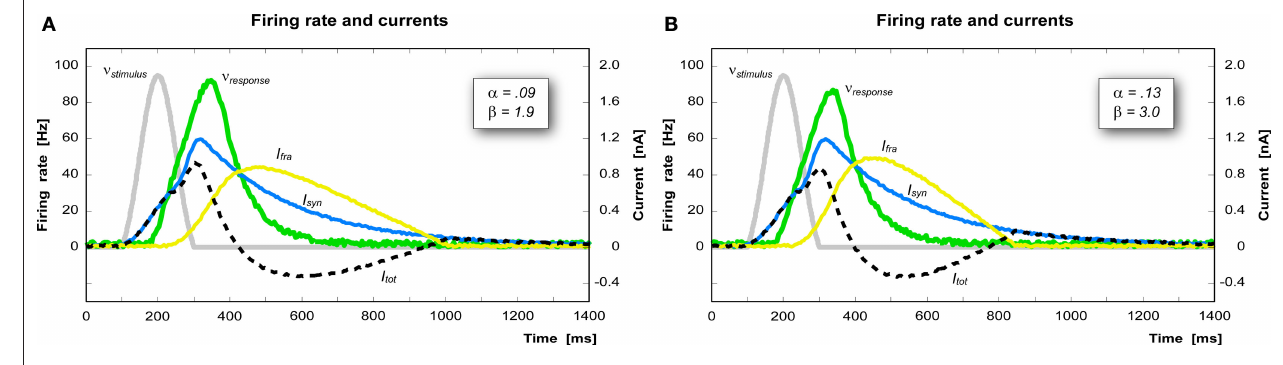
(B) An increase of α (from 0.09 to 0.13 nA) produces a more intense I and thus a stronger inhibition in case of re-activation of the same pool within 700